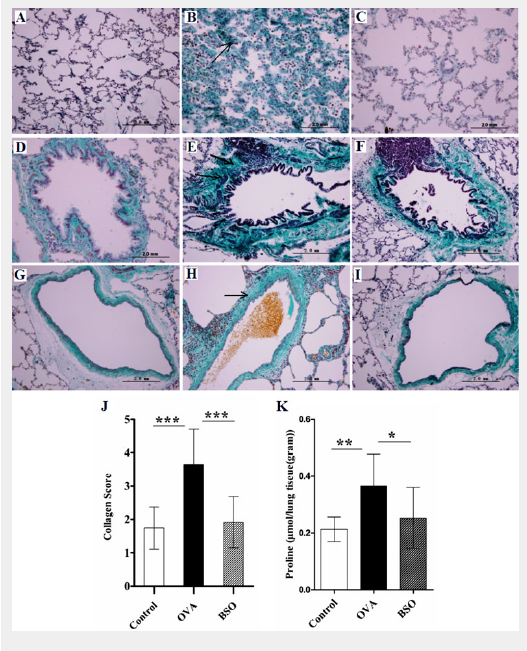
BSO attenuated the collagen deposition and proline level. The lung tissue from experimental rats was stained by Masson’s trichome method. A, D and G represent lung sections of control rats, showing normal level of collagen. B, E and H show lung sections of OVA challenged rats, indicating deposition of collagen around airways, blood vessels and alveolar wall. C, F and I show sections from OVA challenged and BSO treated rats. BSO administration decreased the collagen deposition in the lung. In the representative histological images, A, B and C indicate parenchymal interstitium in alveolar area, D, E and F peribronchial and G, H and I perivascular connective tissues. In all figures, magnification is 400X. The score for collagen deposition and proline level in the lung homogenate is shown in J and K respectively. Arrows show thickening of alveolar septae and deposition of collagen around the bronchus and blood vessels. Data shown as mean ± S.E.M. *P <0.05, **P <0.01 and *** P <0.001 compared between two group.